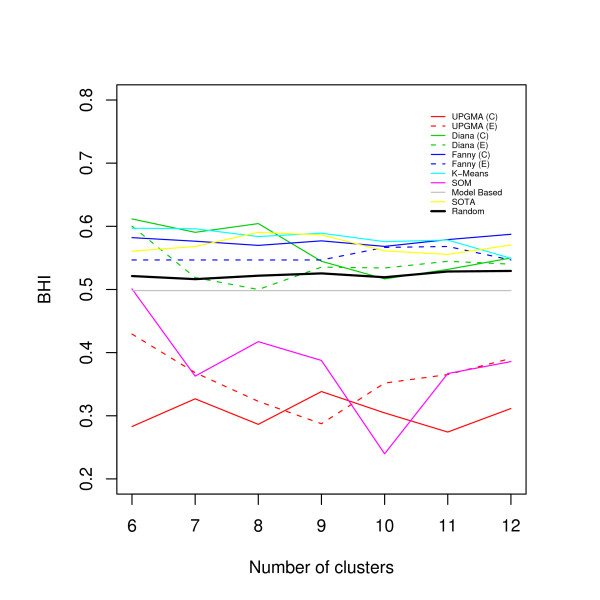
BHI for various clustering algorithms applied to the positively expressed genes in yeast sporulation data with functional classes from FatiGO. The thick black line is the 95th percentile of BHI values under random clustering.